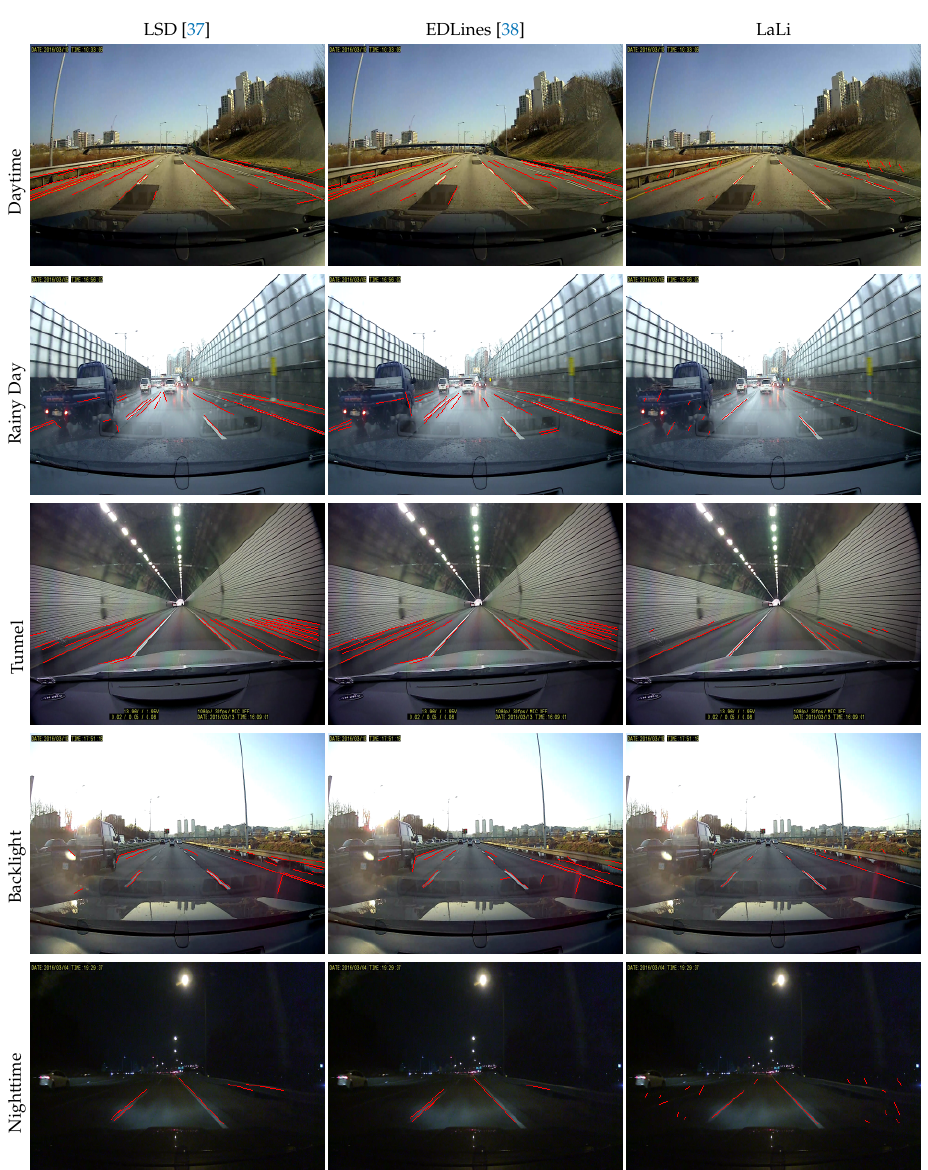
Figure 11. Sample results of line segment extraction on KIST